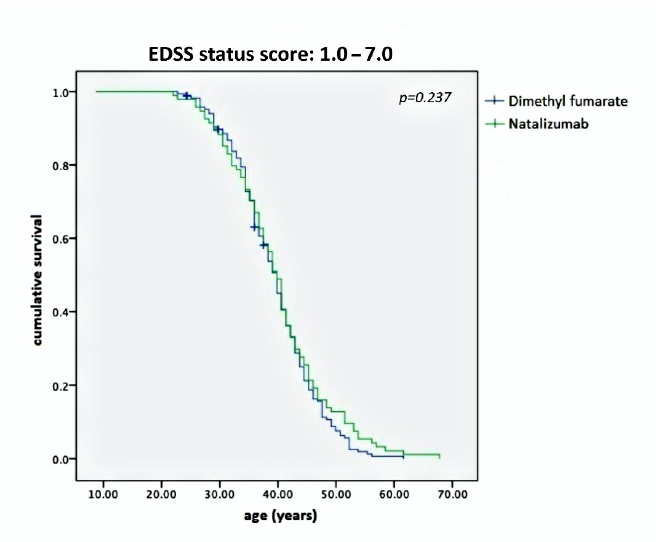
Figure 2. Kaplan–Meier curves comparing reaching an EDSS status score of 1.0–7.0 over the long age period in both NTZ- and DMF-treated MS study populations. Note that the two curves are largely superimposed, indicating the same timing in reaching the functional milestones for NTZ- and DMF- treated patients. That means the two study populations were homogeneous and statistically comparable.